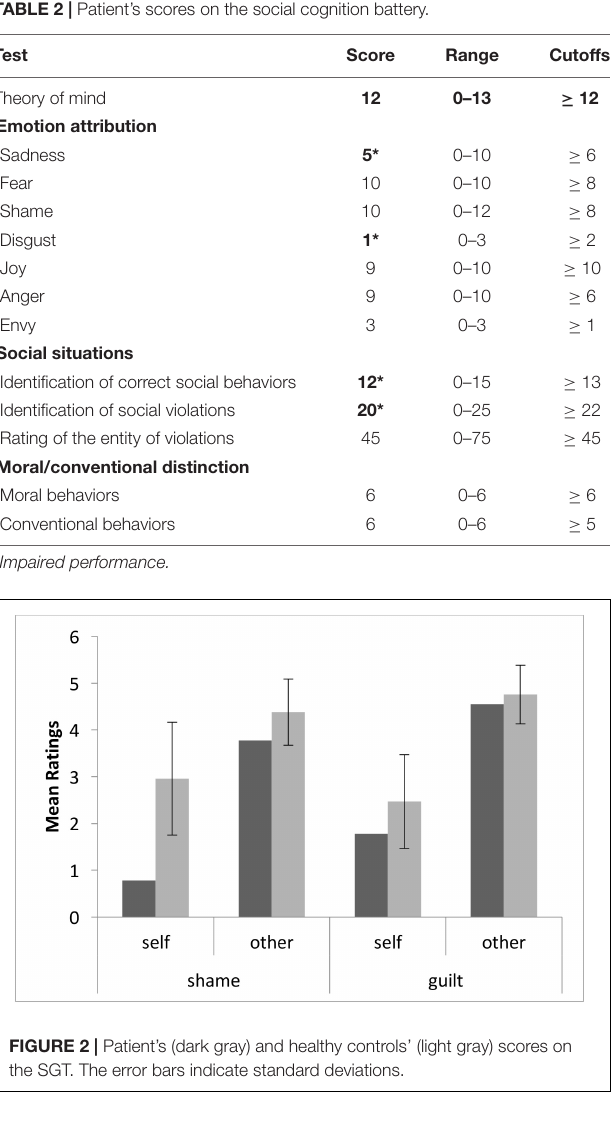
and envy was above the cutoff. It is worth noting that errors